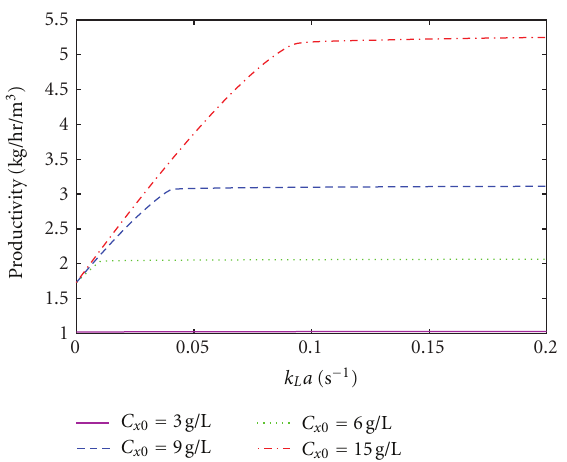
Figure 5: E ff ect of the volumetric mass transfer coe ffi cient on the reactor productivity ( P T = 3atm, G/L = 0.20, and U L = 0 . 5m/s).